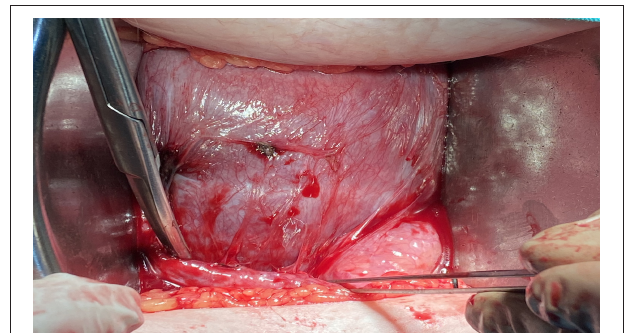
FIGURE 4 | Intraoperative aspect of the lower uterine segment during the caesarean section for the current pregnancy. The lower segment is thick with a fully healed scar with no visible